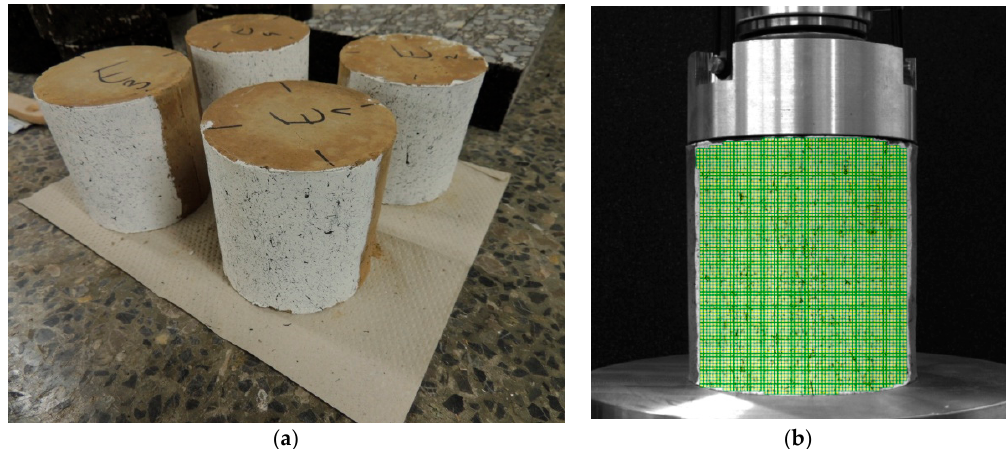
Figure 13. Soil samples: ( a ) View of the samples prepared for the compressive test; ( b ) virtual grid on the surface of the sample [40]. the surface of the sample